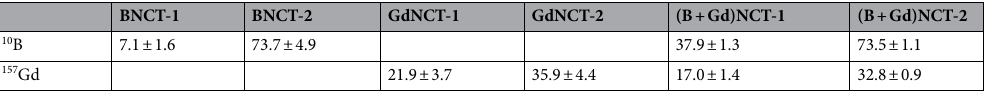
Table 1. Intracellular boron and gadolinium concentrations (ppm) in CT26 cells determined using inductively coupled plasma atomic emission spectroscopy. Data are presented as mean ± standard deviation (SD) of